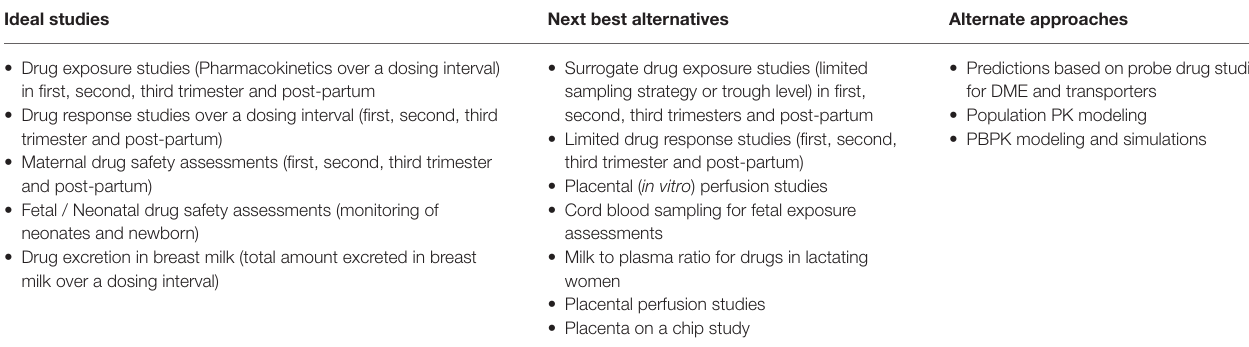
TABLE 2 | Ideal studies in pregnancy and alternative approaches.